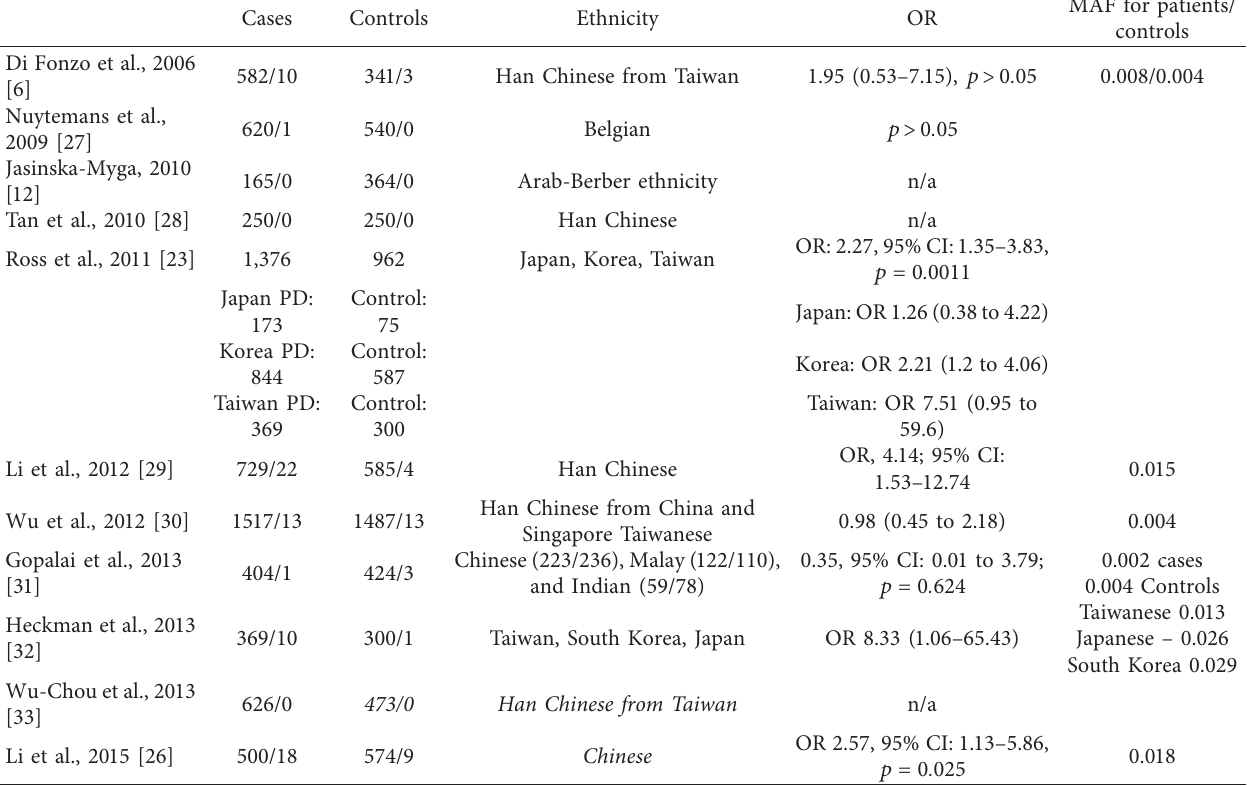
Table 7: Studies investigating LRRK2 p.Ala419Val variant in Asian